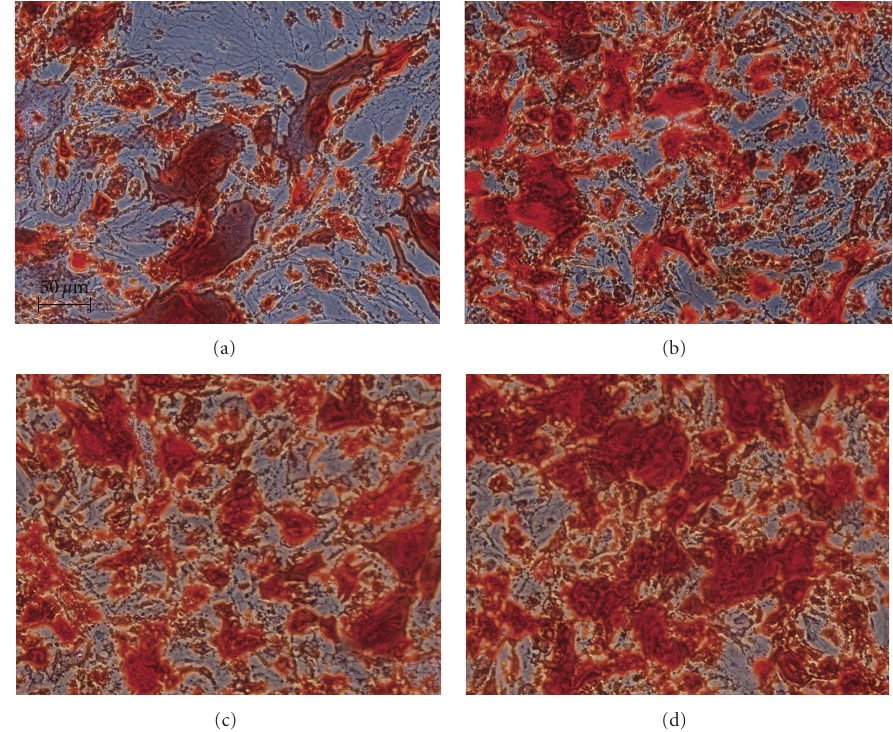
Figure 3: Alizarin red S staining for (a) control group, (b) BMP2/ADSCs group, (c) BMP7/ADSCs group, and (d) BMP2 + BMP7/ADSCs group at 14 days after cell seeding. Bar = 50 μ m.